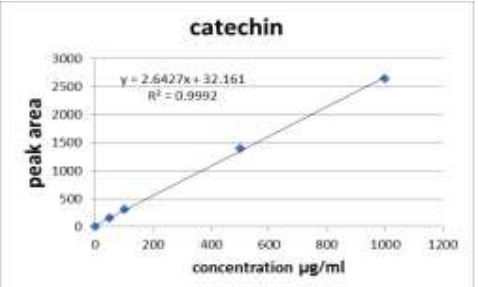
Table 4. Quantitative analysis of ethyl acetate